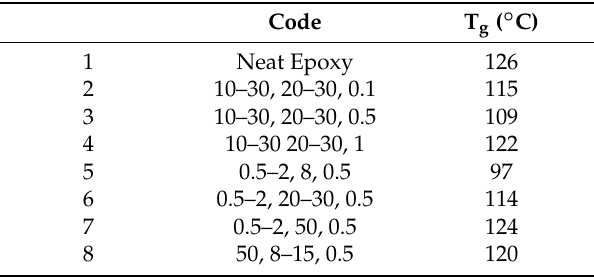
Table 6. Glass transition temperature of all